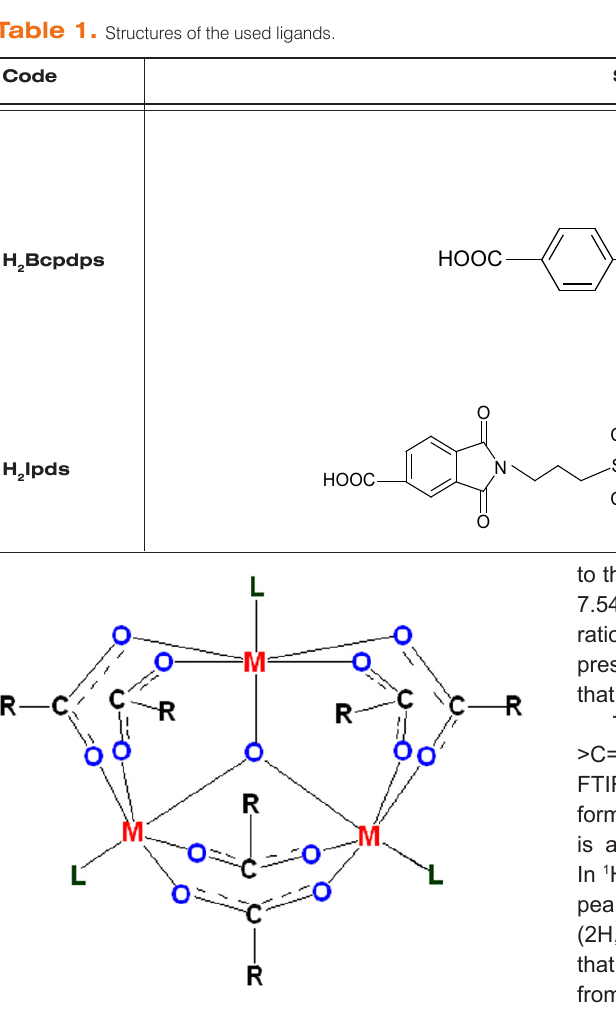
Figure 1. The distribution of atoms and chemical bonds in trinuclear